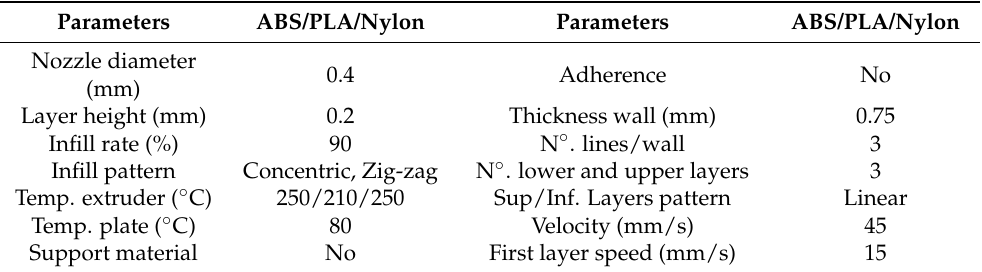
Table 3. Ultimaker/Cura printing